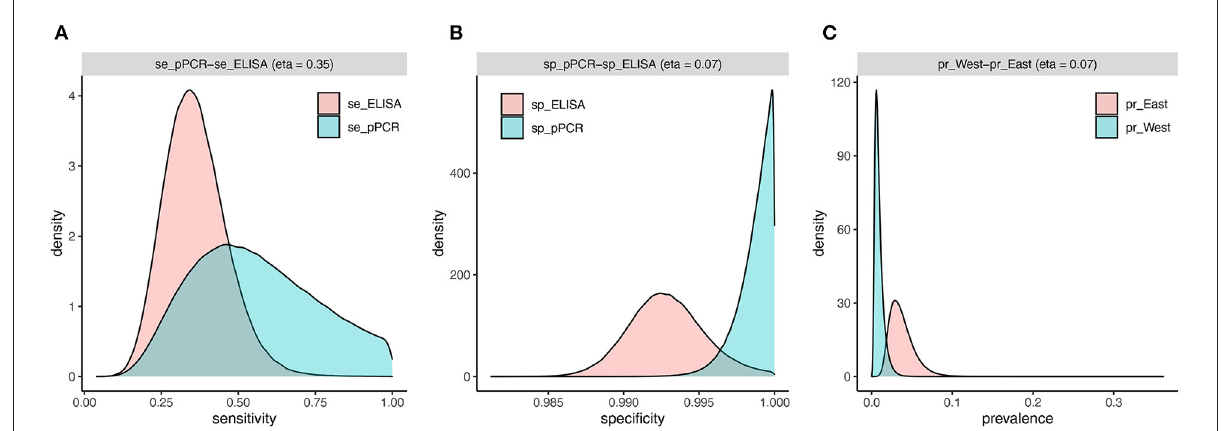
FIGURE4 Estimated densities and overlap of posterior distributions from individual-level BLCM ( n = 3,171 cows) for sensitivity (A) and specificity (B) of pooled PCR and ELISA, and prevalence (C) in the west and east